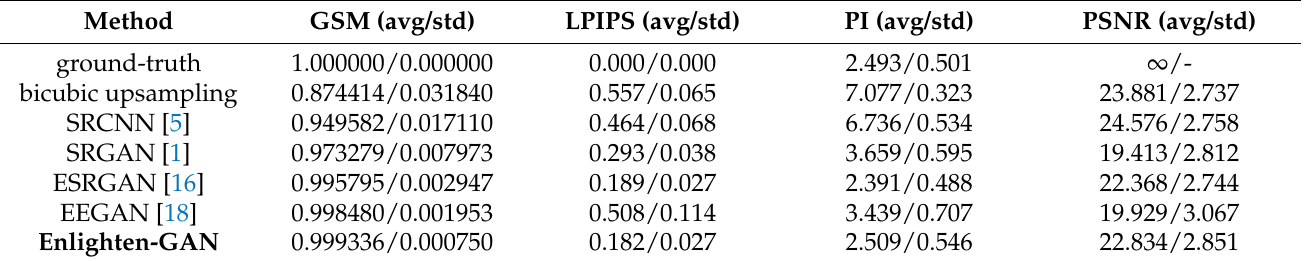
Table 1. The metrics of SR and HR images from varied